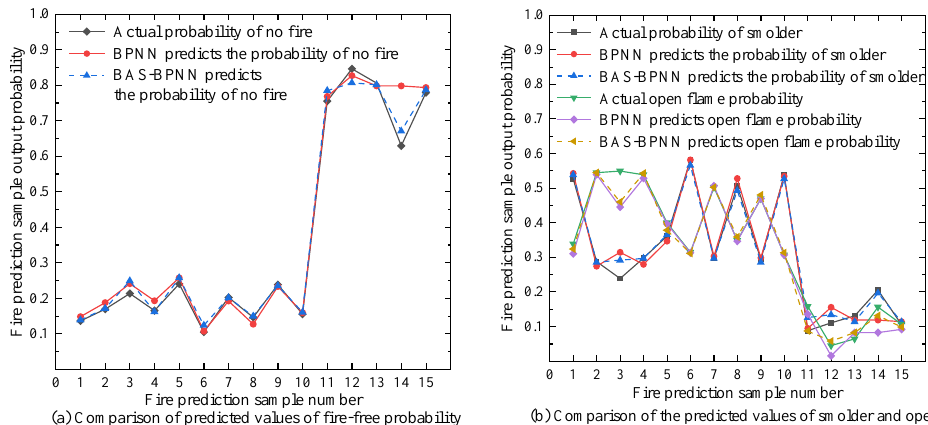
Figure 10. Comparison of fire probability prediction values.